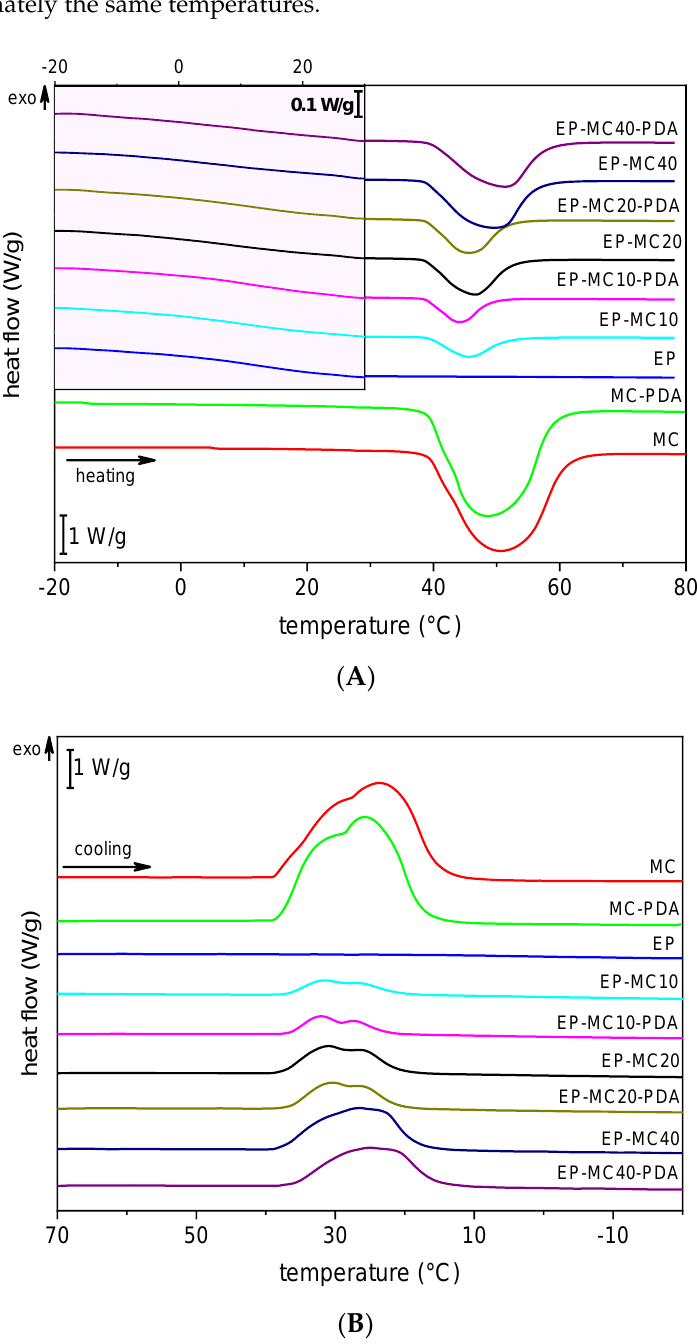
Figure 4. Results of DSC tests on neat and PDA-coated microcapsules and prepared composites. ( A ) First heating scan. The shaded box reports the thermograms with a magnified y -scale to highlight the glass transition of the EP matrix. ( B ) Cooling scan.